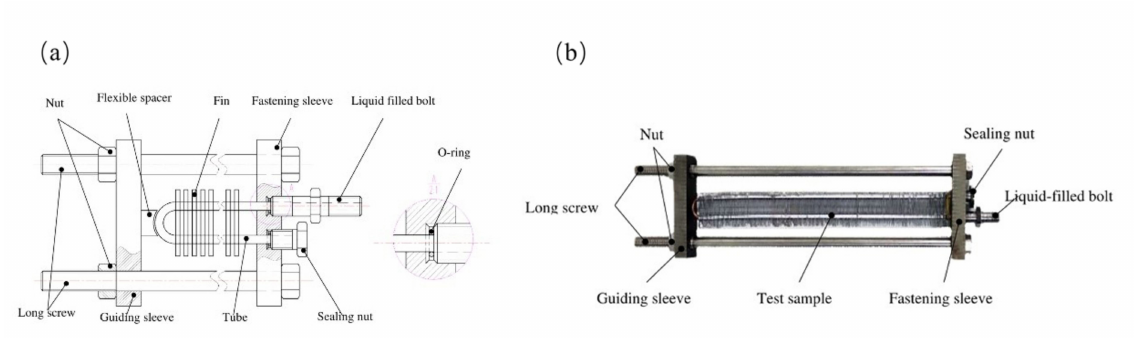
Figure 4. The hydraulic expansion device and sealing part. ( a ) The design of the device; ( b ) The photo of